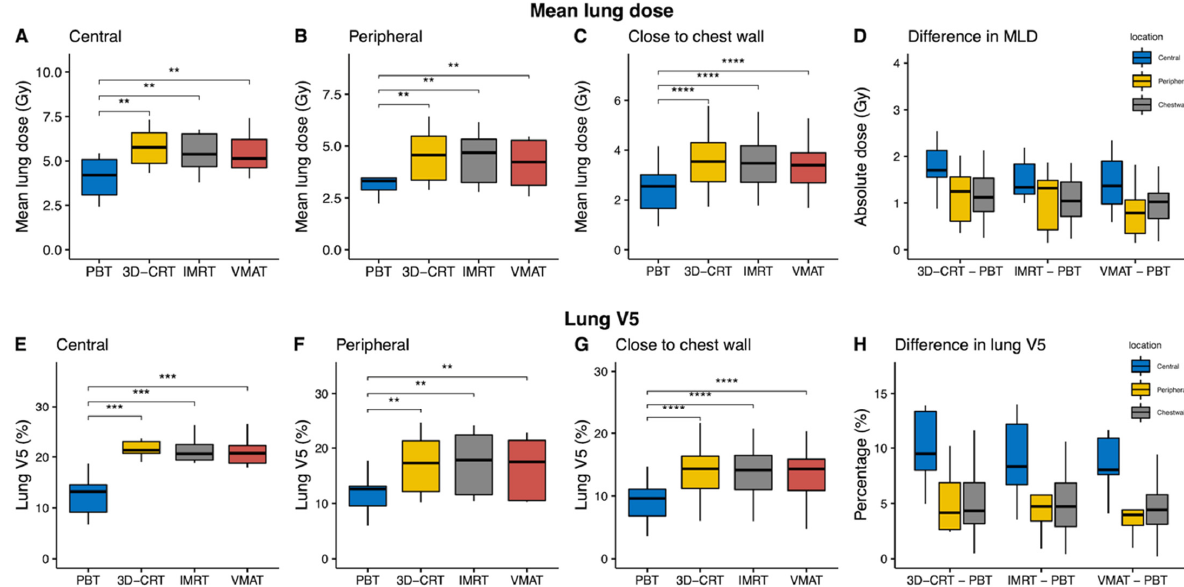
Figure 2. Mean lung dose (MLD) and lung V5 comparisons according to treatment modality and with regard to tumor locations. Dosimetric parameters for proton beam therapy (PBT) were statistically significantly improved as compared with other photon plans at each location. ( A – C ) Boxplots of the MLD are shown in units of absolute dose per location. ( D ) Boxplots of median differences in the MLD between photon-based radiotherapy techniques and PBT. ( E – G ) Boxplots of the percentage of the lung receiving 5 Gy in each subgroup. ( H ) Median differences in lung V5 between photon-based radiotherapies and PBT. ** p ≤ 0.01; *** p ≤ 0.001; **** p ≤ 0.0001. Table 2. Summary and comparison of the dosimetric parameters of centrally located tumors (50 CGE/4 fx = 4, 70 CGE/10 fx = 5, and 60 CGE/10 fx = 2). OARs